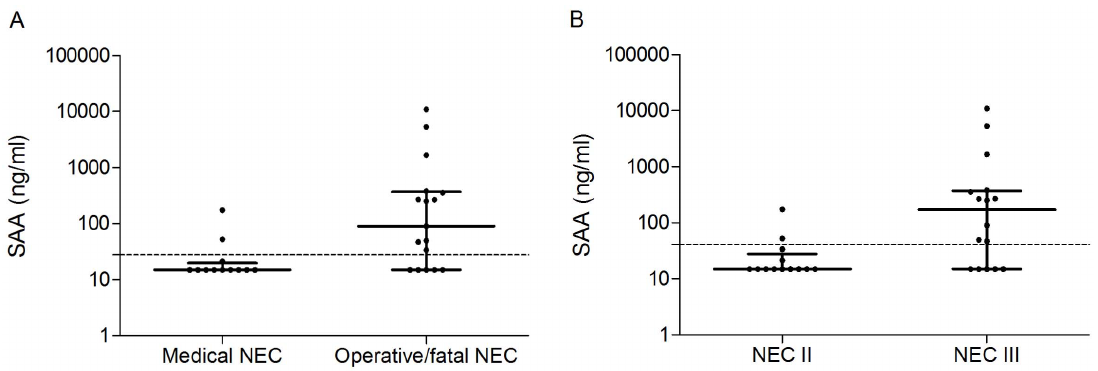
Figure 1. A. Urinary SAA levels at diagnosis (D) in the medical NEC group compared with the operative/fatal NEC group. The dotted line represents the ideal cut-off value of 27.8 ng/ml. B. Urinary SAA levels at diagnosis (D) in the NEC stage II group compared with the NEC stage III group. The dotted line represents the ideal cut-off value of 40.7 ng/ml.